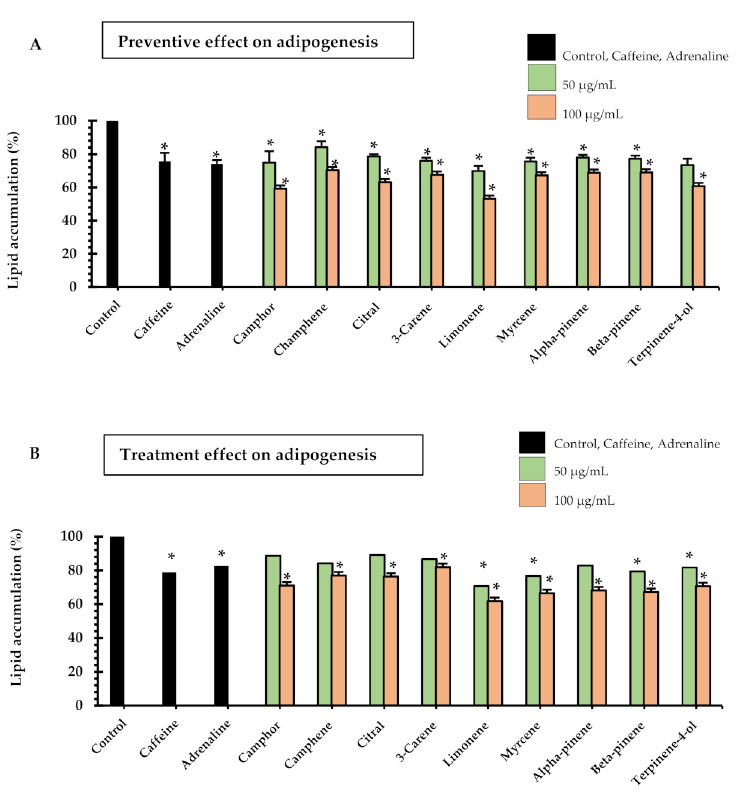
Figure 2. Lipid accumulation in 3T3-L1 adipocytes after treated with monoterpenoid constituents of the herbal compress ingredients and positive controls (adrenaline 0.1 mM or 18.3 µ g/mL and caffeine 1 mM or 194.2 µ g/mL); ( A ) in the preventive experiments where the pre-adipocytes were treated with the samples during the differentiation on days 3, 5 and 7, and ( B ) in the treatment experiments where the samples were added after the pre-adipocytes were differentiated to adipocytes (on day 9) and incubated for one day. The lipid accumulation was measured by Oil Red O assay, and the results expressed as the mean ± SEM of triplicate tests. Data expressed in percentage in comparison with control. One-way ANOVA showed significant value, * p < 0.05 as compared to